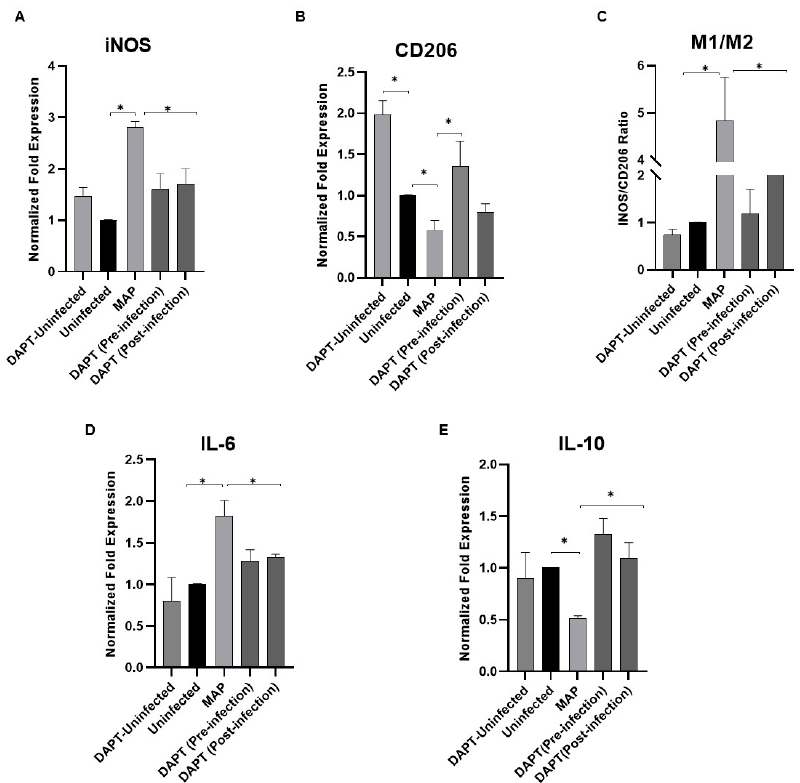
Figure 7. Notch-1 signaling modulates macrophage polarization in MAP-infected macrophages. Expression levels of iNOS ( A ), CD206 ( B ), IL-6 ( D ) and IL-10 ( E ) were measured using RT-PCR. M1/M2 ratio was determined by calculating the expression ratio of iNOS/CD206 ( C ). All experiments were performed in triplets. Data are shown as mean ± SD, and significance is considered as * p <